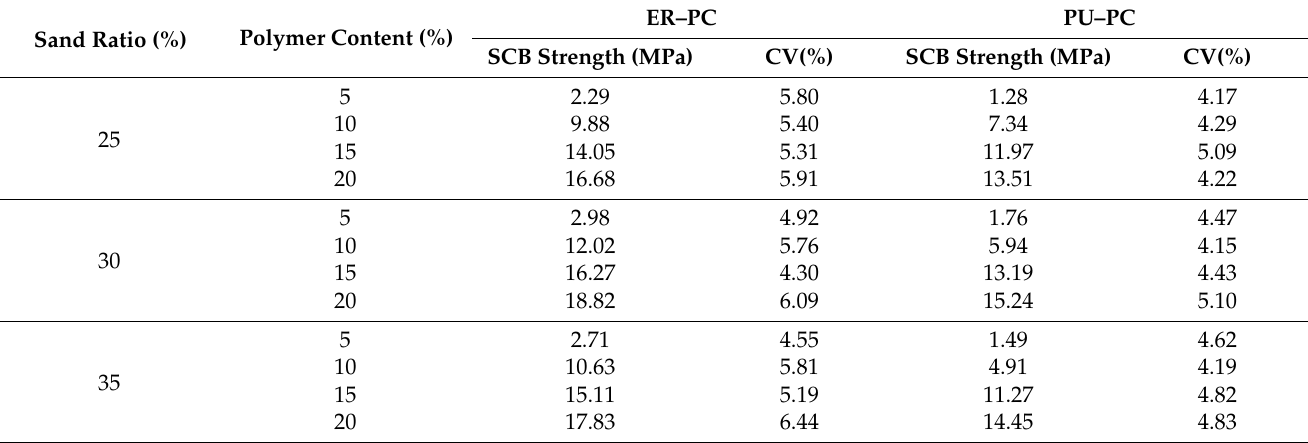
Table 4. SCB strength with different sand ratio and polymer